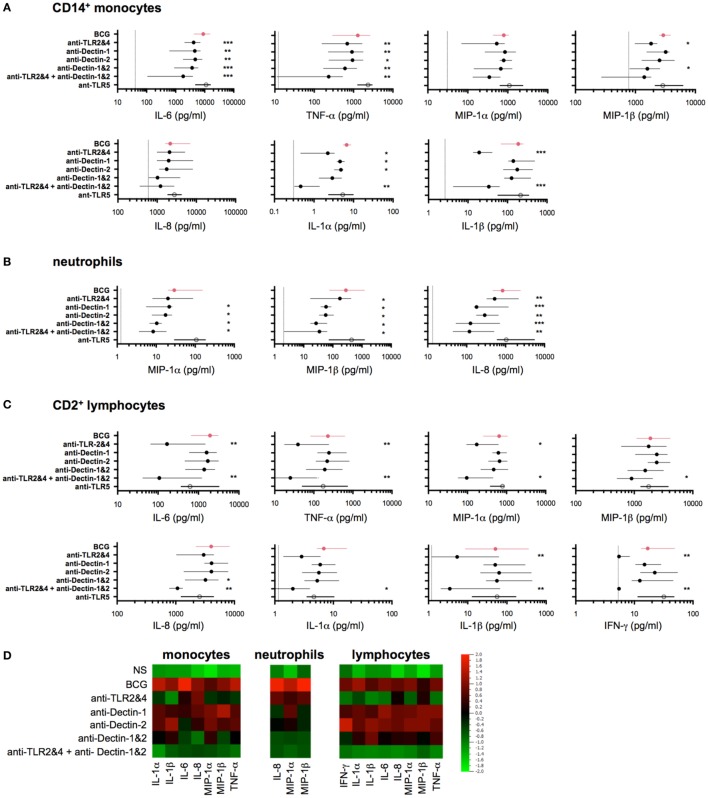
Bacillus Calmette–Guérin (BCG) engagement of multiple toll-like receptors (TLRs) and C-type lectin-like receptors accounts for early release of induced cytokines. (A–C) Concentrations of selected cytokines measured by Luminex assay from purified CD14+ monocytes [(A), n = 5–8], CD66b+ neutrophils [(B), n = 8)], and CD2+ lymphocytes [(C), n = 8] each stimulated with BCG in the presence of indicated neutralizing antibodies (black circles) or isotype control antibodies (red circles) or neutralizing anti-TLR5 (white circle), for 5 h (monocytes and neutrophils) or 16 h (lymphocytes). Filled circles indicate the median concentration for each condition, and the lines represent the interquartile (IQR1/3) range. The dotted lines indicate the respective median values for unstimulated samples; if not shown, the null condition was below the limit of detection for the given assay. (D) Heat map representation using the median concentration determined from data represented above. p Values were determined by the paired Student’s t test and false discovery rate corrected for multiple analyte testing. *q ≤ 0.05; **q ≤ 0.01; ***q ≤ 0.001 as compared to BCG + isotype control antibody.